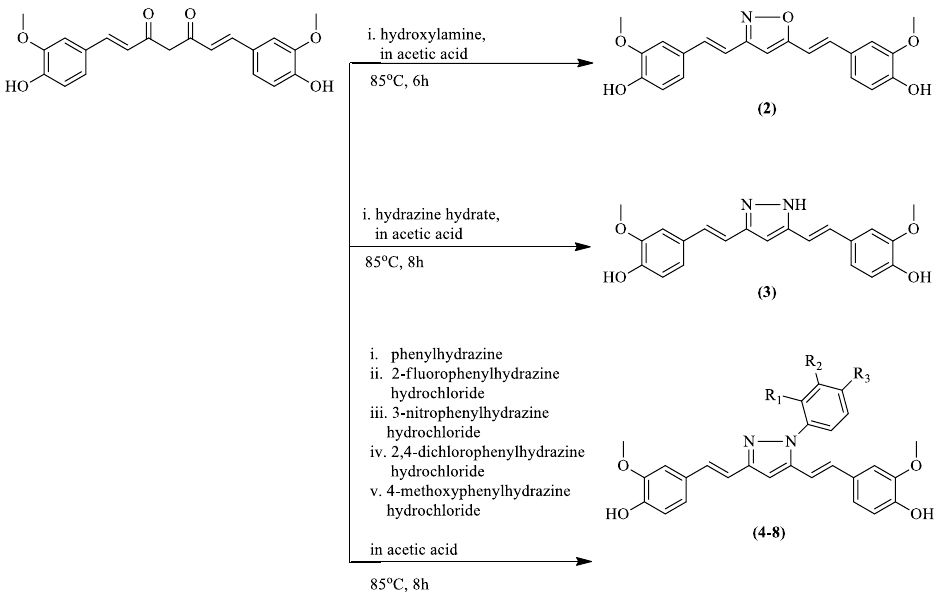
Figure 10. Reaction scheme showing the synthesis of isoxazole and pyrazole derivatives of